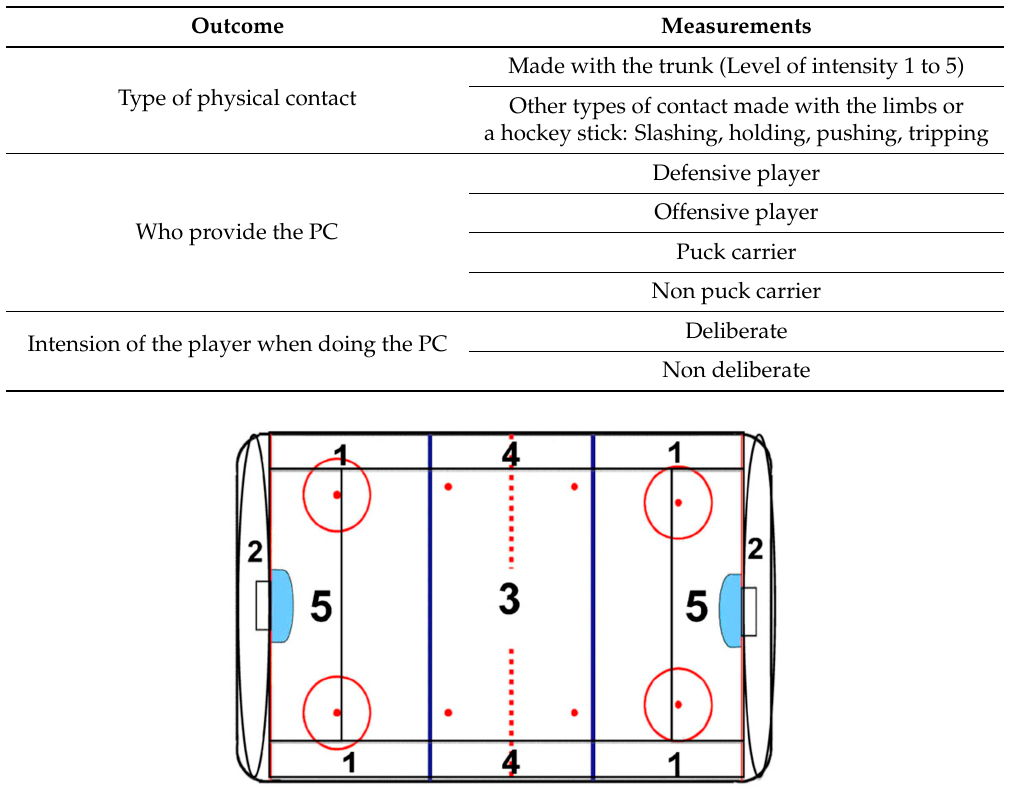
Figure 1. Definition of the zones on the playing surface. Numbers indicate the zones where a physical contact may occur.